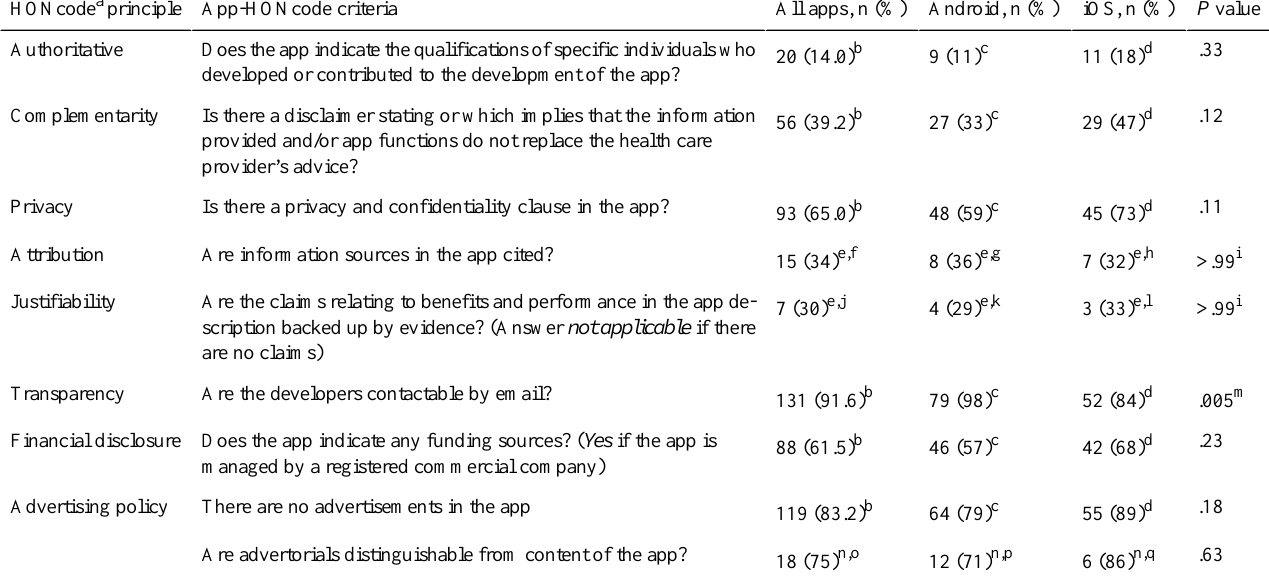
Table 2. Profile of app attribute grouped by